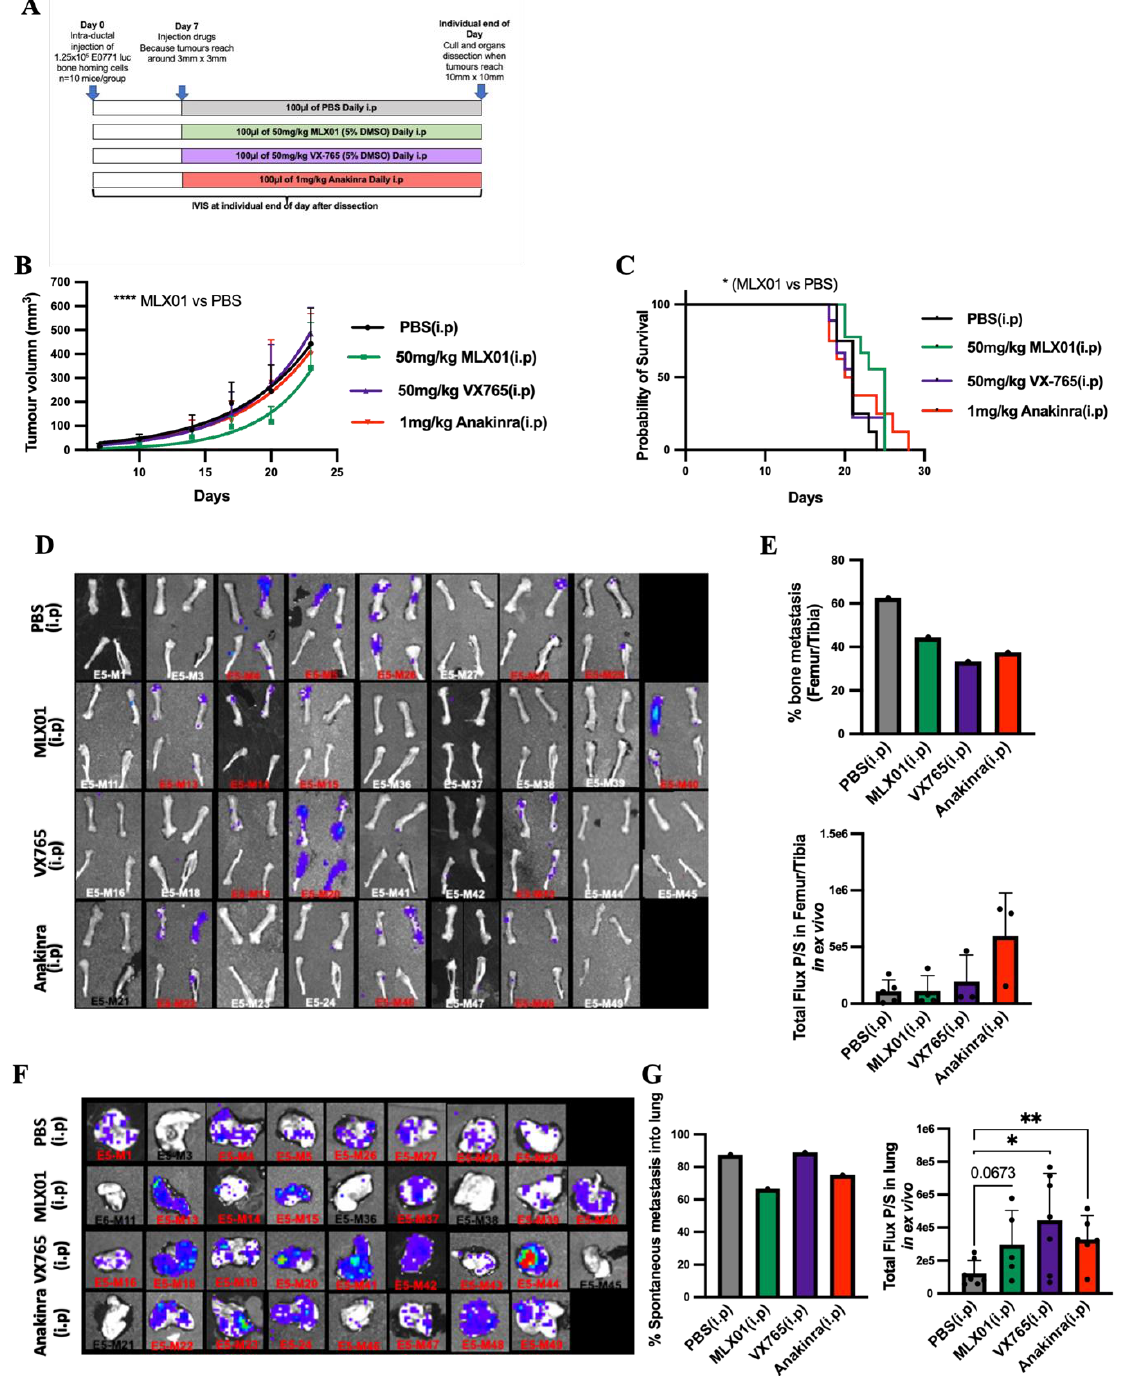
Figure 4. The effect of inhibiting signalling of the IL-1 pathway on growth of E0771 cells in mammary glands and spontaneous metastasis to lung and bone ( A ) Protocol outline for orthotopic injection of E0771 cells into mammary glands and administration of PBS (control), MLX01, VX765 or Anakinra in mice. ( B ) Primary tumour volume following daily administration of PBS (control), MLX01, VX765 or Anakinra. ( C ) Survival curve ( D ) IVIS images of dissected femur/tibia ex vivo following exposure to D-luciferin for 5 min. ( E ) Percentage of mice that developed spontaneous bone metastasis and size of tumours in femurs/tibiae as assessed ex vivo by IVIS. ( F ) IVIS images of dissected lungs, ex vivo ( G ) Percentage of mice that developed spontaneous lung metastasis and size of tumours in lungs as assessed by IVIS, ex vivo. The graphs represent mean ± SD, * p < 0.05, ** p < 0.01, **** p < 0.0001.